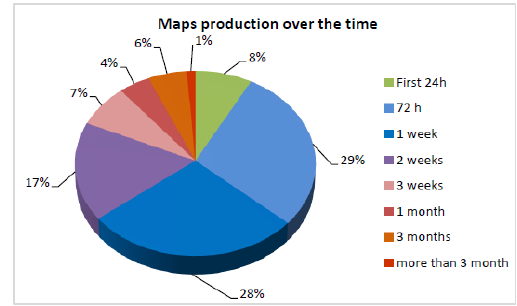
Figure 2. Pie chart of the time gap between crisis event and map production